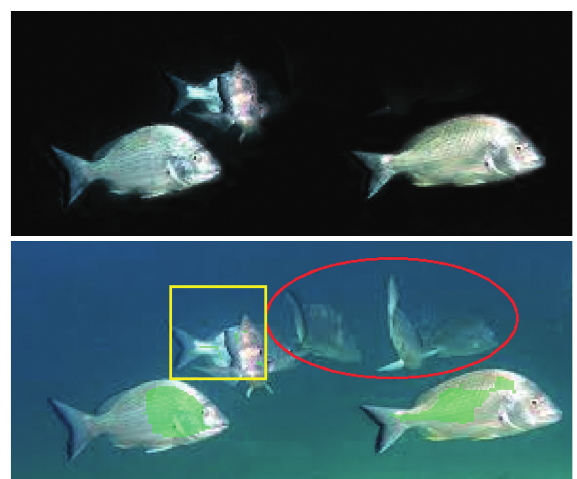
Figure 5: Background subtraction to bring objects (fish) fore- ground for